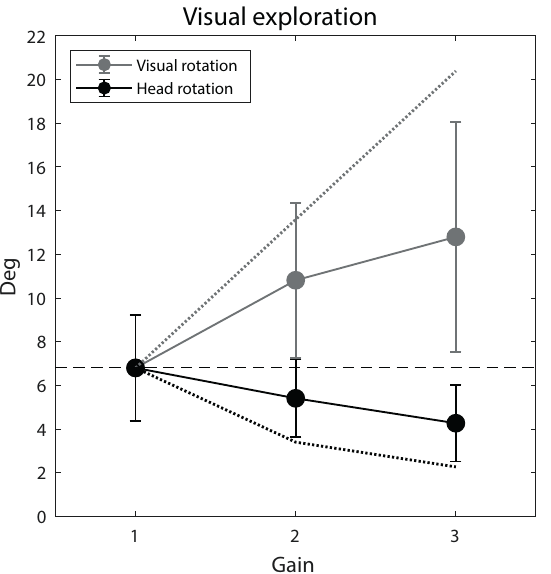
Figure 7. Visual exploratory activity across the three gain levels. Both the mean head rotation (absolute horizontal deviation from straight ahead, black data points) and the contingent mean visual rotation (grey data points) are illustrated. Error bars are 99% confidence intervals of the mean. The two dotted lines represent the condition in which visual exploration would be maximized, with no decrease in head rotation (grey), and the condition in which head rotation would be minimized, with no increase in visual exploration (black). Participants implemented a balanced, intermediate strategy. The dashed line indicates the natural condition (gain = 1.0), where the head and visual rotations